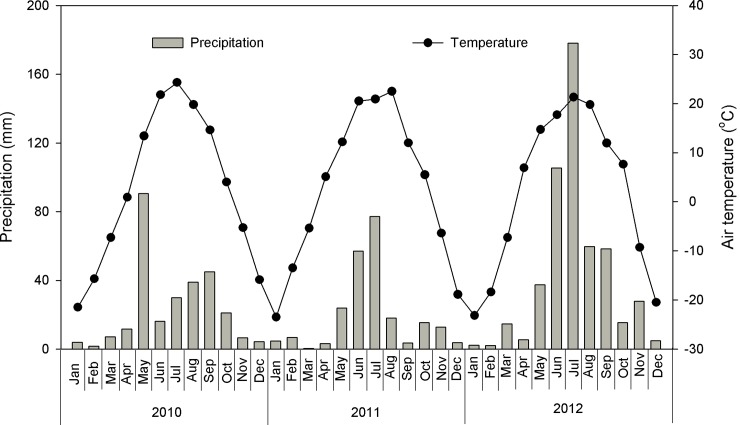
Monthly precipitation (bars) and monthly mean air temperature (line) for 2010–2012.